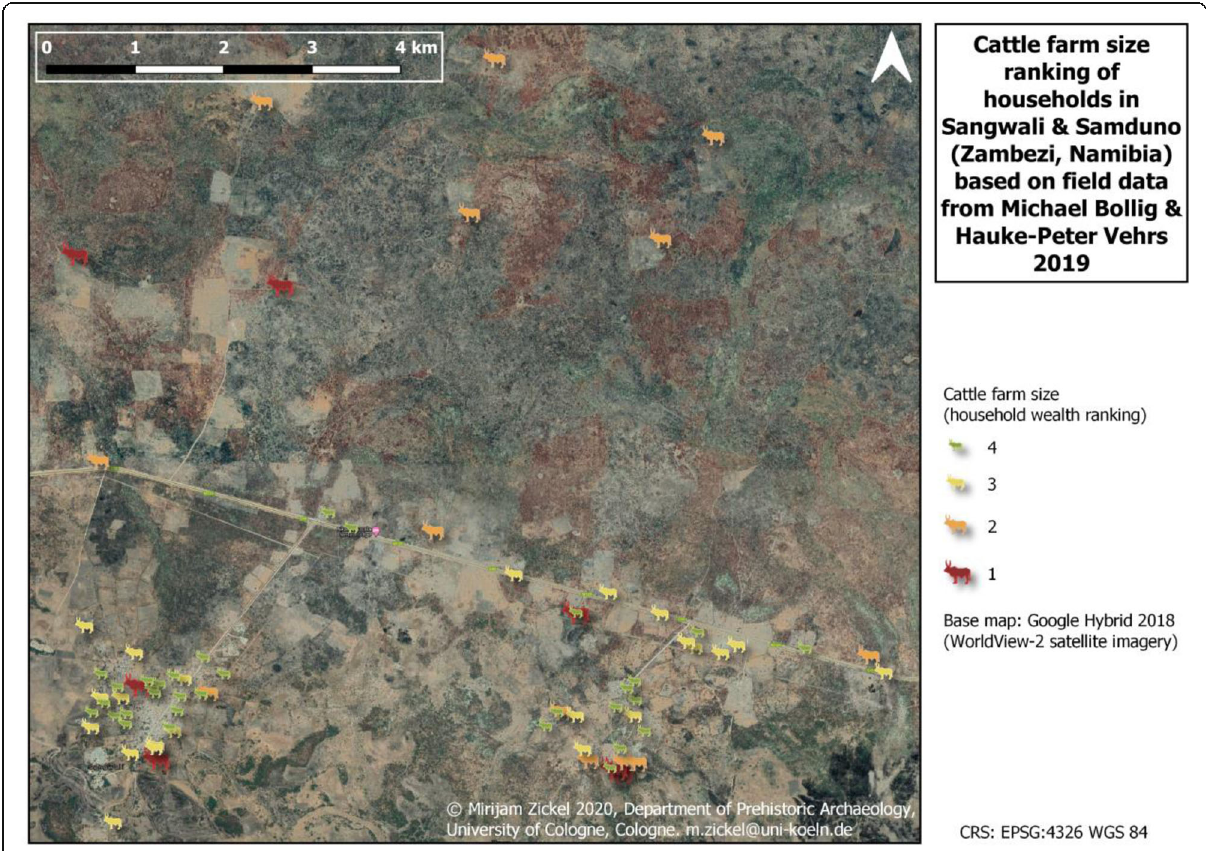
Fig. 3 Cattle farm size ranking of households and location of cattle